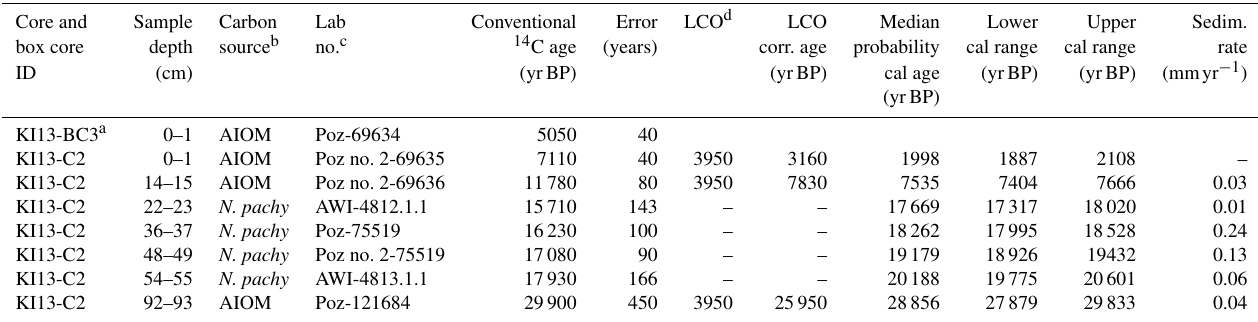
Table 1. AMS 14 C ages with calibrated calendar ages ± 2 σ (years) as well as applied local contamination offset and reservoir age correction (see text) of the studied core. The calendar ages were calibrated using the Clam 2.3.2 software with a Marine13 calibration curve (Reimer et al., 2013). A constant reservoir correction of 1144 ± 121 years with a (cid:49)R of 791 ± 121 years (Hall et al., 2010) was applied. Calibrated age ranges are at 95%